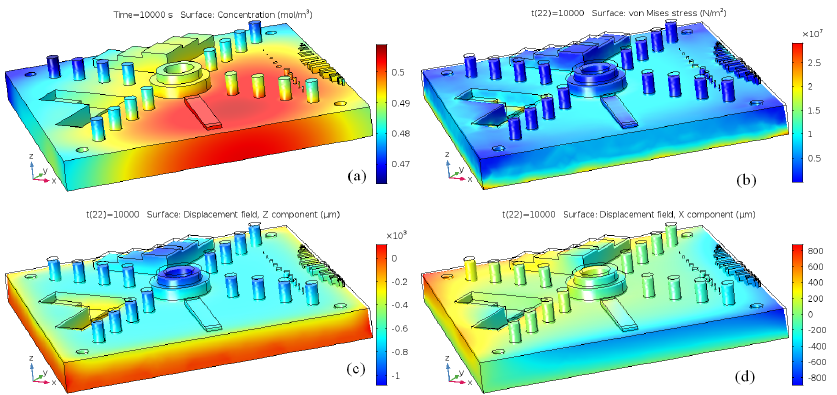
Figure 17. COMSOL simulations of: ( a ) the concentration of backbone debinder in the sintering part (after sintering); ( b ) total displacement; ( c ) directional strain; ( d ) displacement in the vertical direction. The parameters were β = 10 − 3 m 3 /kg, initial concentration 10 3 mol/m 3 , diffusion coefficient D = 4 × 10 − 6 m 2 /s, brown part density was taken as 3000 kg/m 3 , Young’s modulus = 10 GPa, Poisson’s ratio = 0.4.